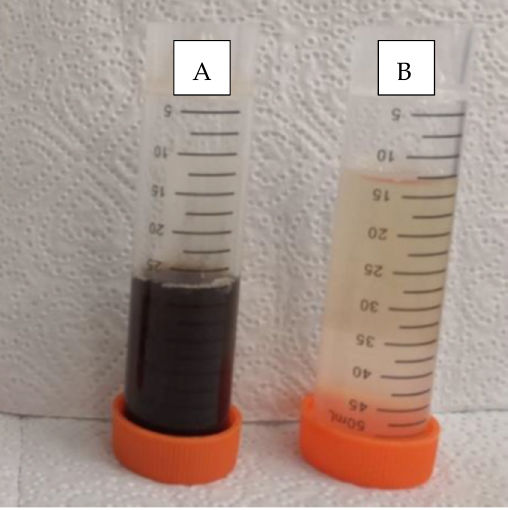
Figure 5. ( A ) NF270 concentrate and ( B ) NF270 permeate of site 2 manure.